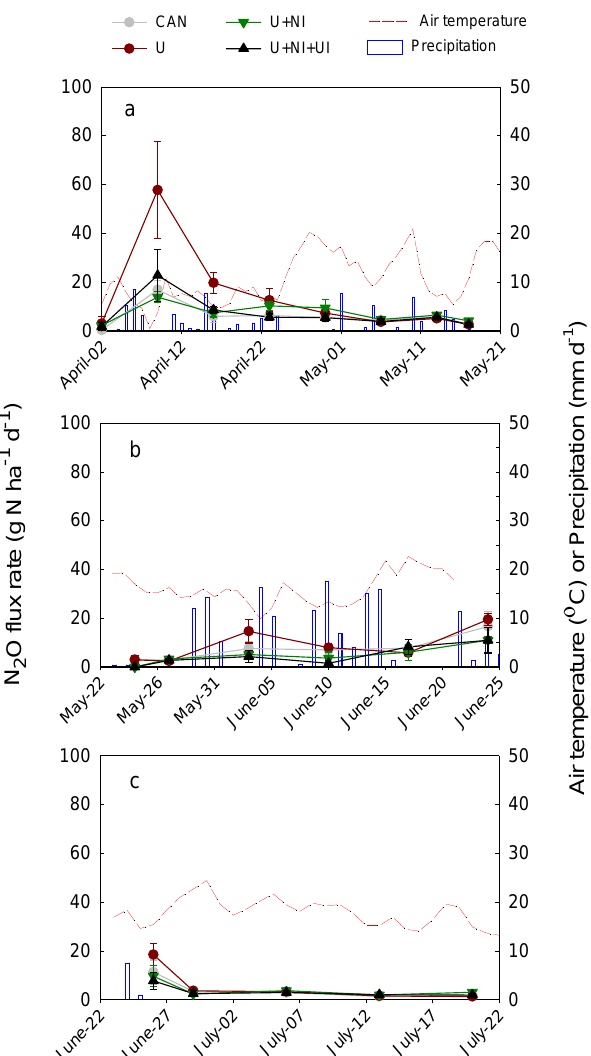
Figure 5. N 2 O flux rate (left vertical axis) and air temperature or precipitation (right vertical axis) for the fertilization treatments (CAN: calcium ammonium nitrate; U: urea; NI: nitrification inhibitor; and UI: urease inhibitor) after the 1st ( a ), 2nd ( b ), and 3rd ( c ) split N application in 2012. The vertical bars indicate the standard deviation of the mean (n = 3).